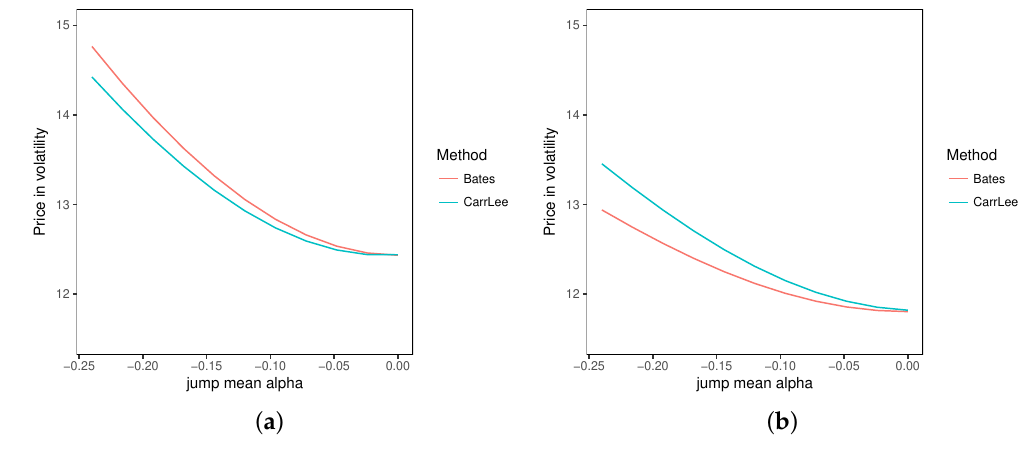
Figure 3. Effect of jumps on the price of variance and volatility swaps using the Bates parameters from Broadie and Jain (2008). ( a ) Variance swap prices; ( b ) volatility swap